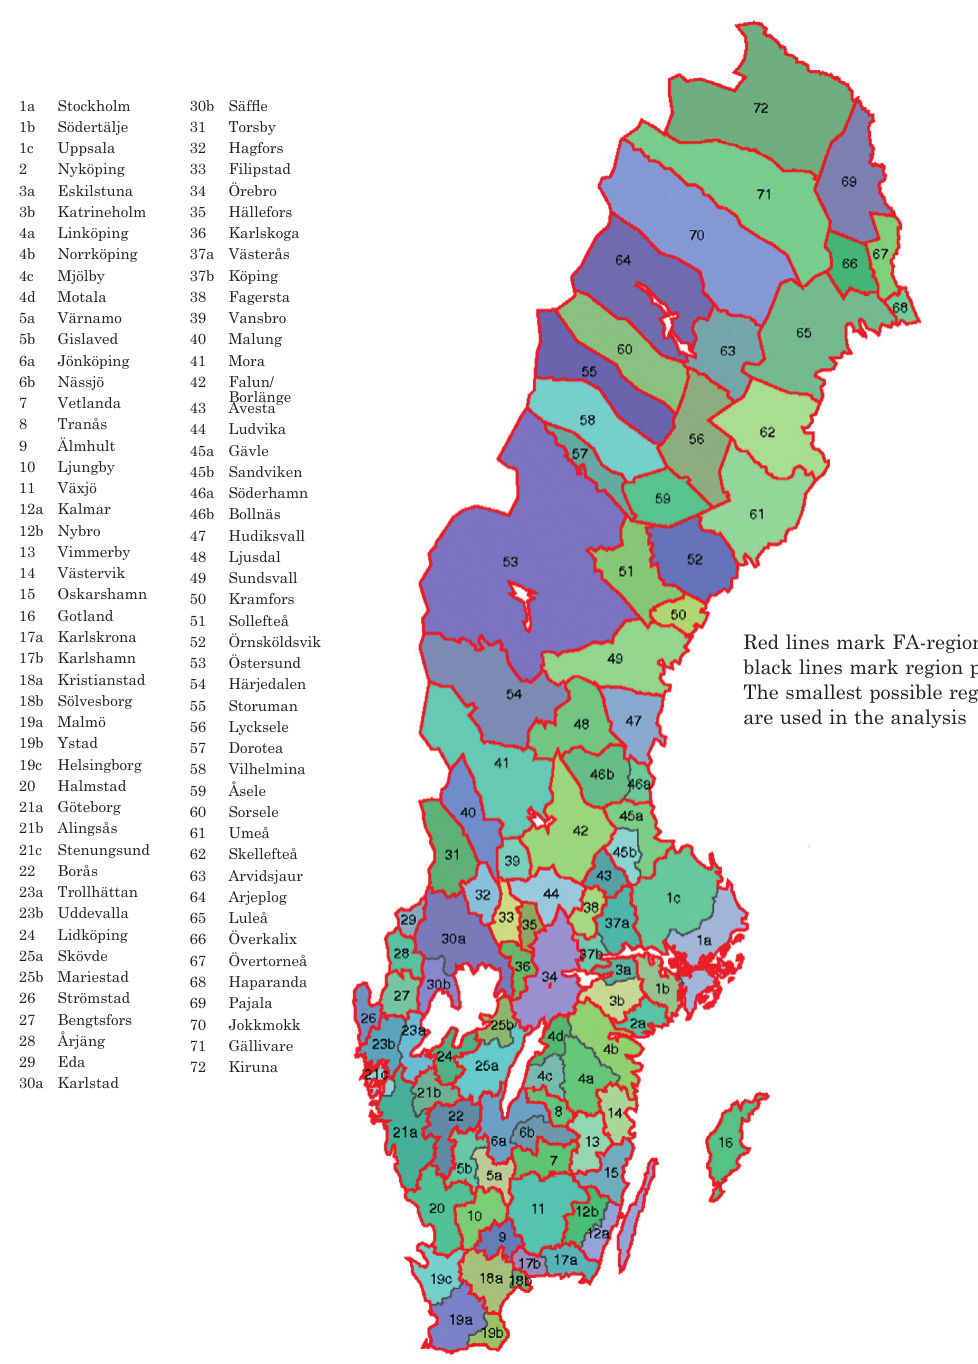
Red lines mark FA-regions, black lines mark region